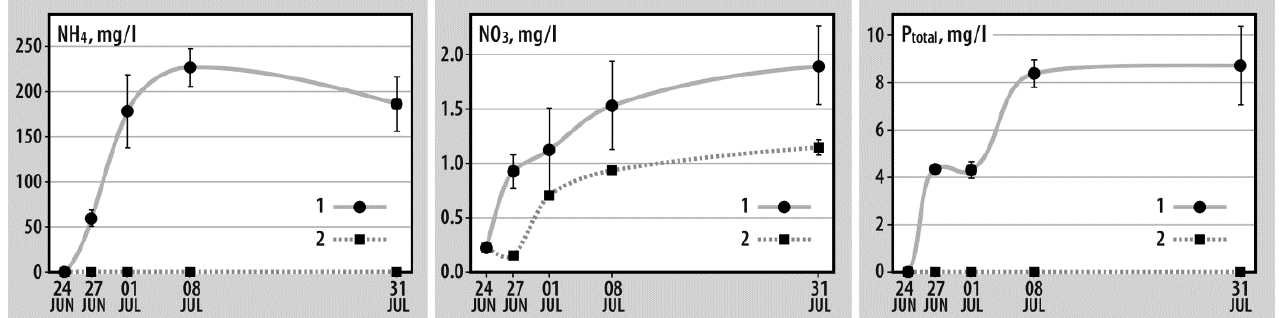
Figure 2. Dynamics of NH 4 , NO 3 , and P total concentrations (mg/L) in experimental (with decomposing snail tissues) (1) and in control containers (2).